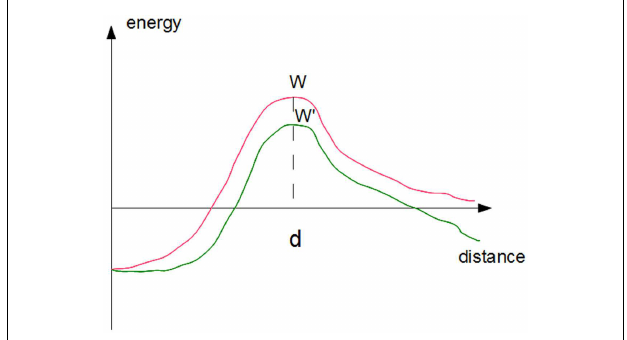
FIGURE 2 | Effect of forces on the kinetics of bond rupture .The simplest approximation consists of representing the free energy of a ligand-receptor complex as a simple function of the distance between ligand and receptor surfaces (red curve). Rupture requires the crossing of an energy barrier of height W .The rupture rate may be viewed as the product of the frequency of attempts at crossing times the success probability that is proportional to Boltzmann’s factor exp( − W / k B T). Applying a force will decrease the barrier height by the product F . d , i.e., the force times the distance between the barrier and the equilibrium distance, thus multiplying the escape frequency by exp( Fd / k B